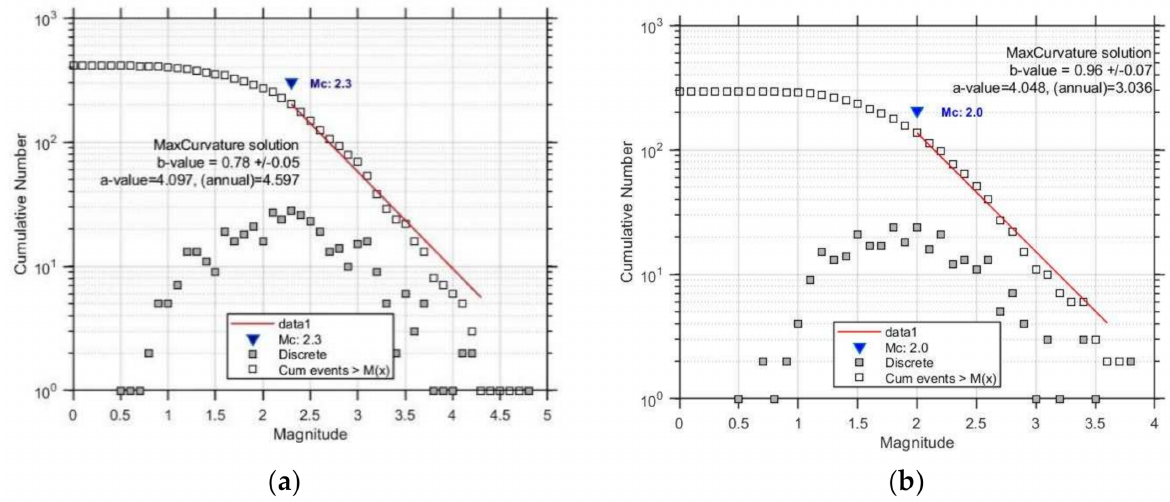
Figure 10. Frequency-magnitude distribution (FMD) for foreshocks ( a ) and for the background seismicity ( b ) in the Arkalochori